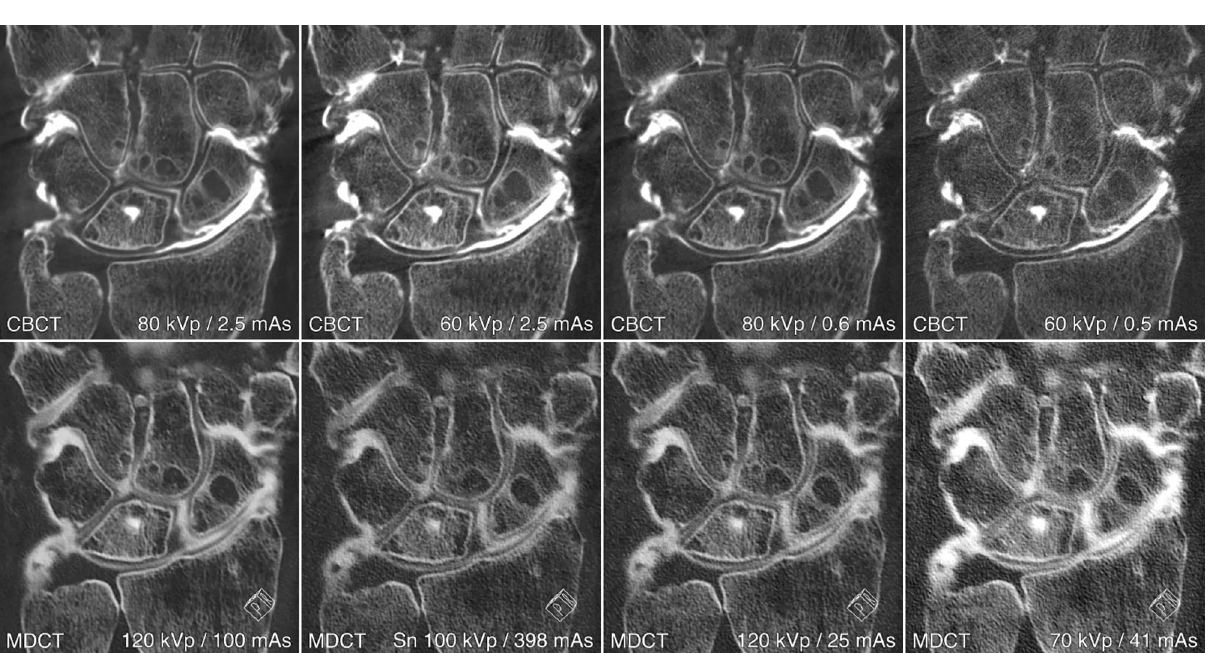
either scanner are shown in Table 3. Interrater reliability was moderate—good for bone tissue (ICC 0.690 [95% confidence interval 0.555–0.787; p < 0.001]), cartilage (0.756 [0.672–0.823; p < 0.001]) and ligament assessment (0.689 [0.586–0.772; p < 0.001]). Image noise was lowest and highest in CBCTA scans with 80 kVp/2.5 mAs and 60 kVp/0.5 mAs, respectively. For MDCTA, lowest and highest noise was measured in examinations with 120 kVp/100 mAs and 70 kVp/41 mAs. Detailed noise levels are presented in Table 4.